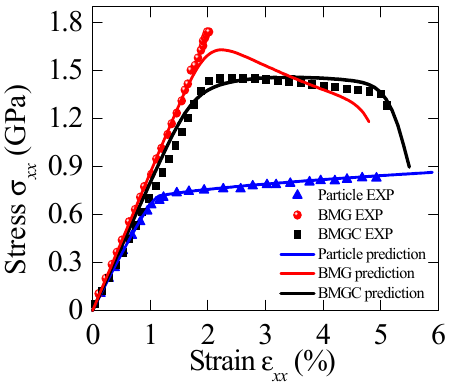
Figure 2. Comparison between the predictions and experiments for the BMGCs with dendrite volume fraction of c 1 = 20% [18]. ε 0 = 0.04 and m = 18 are adopted in the computation.